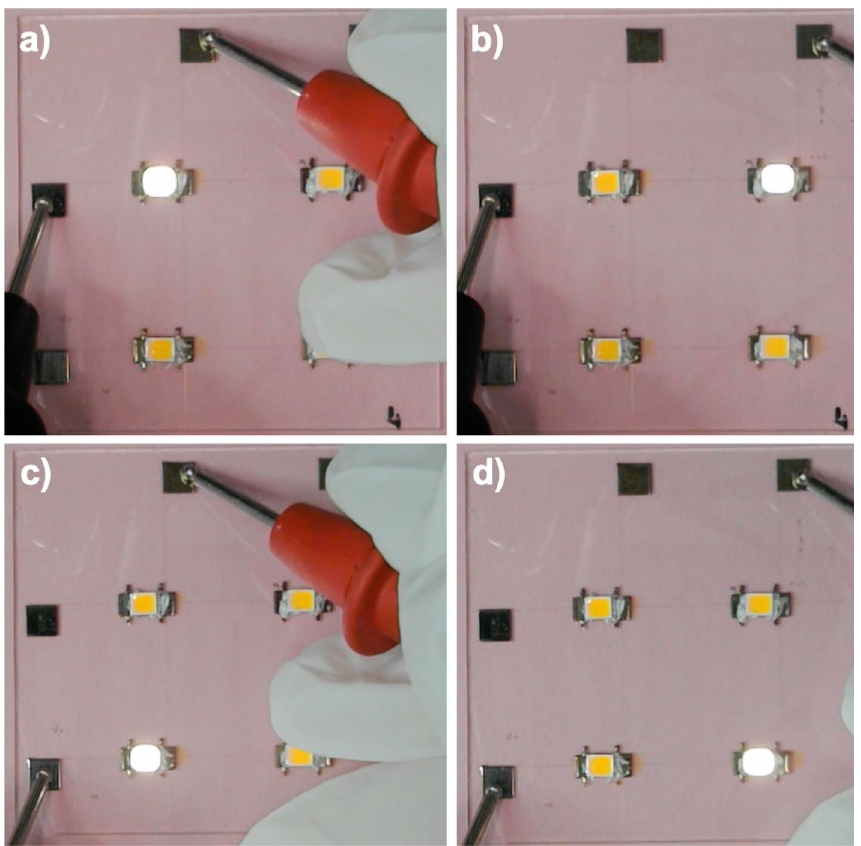
Figure 17. 2 × 2 matrix consisting of Surface Mounted Device (SMD) LEDs and powered using printed silver lines made from CL85 paste. The matrix size is 5 × 5 cm and the line width is around 16 µm. Mounting the LEDs and measurements: courtesy of dr. Selen Solak from